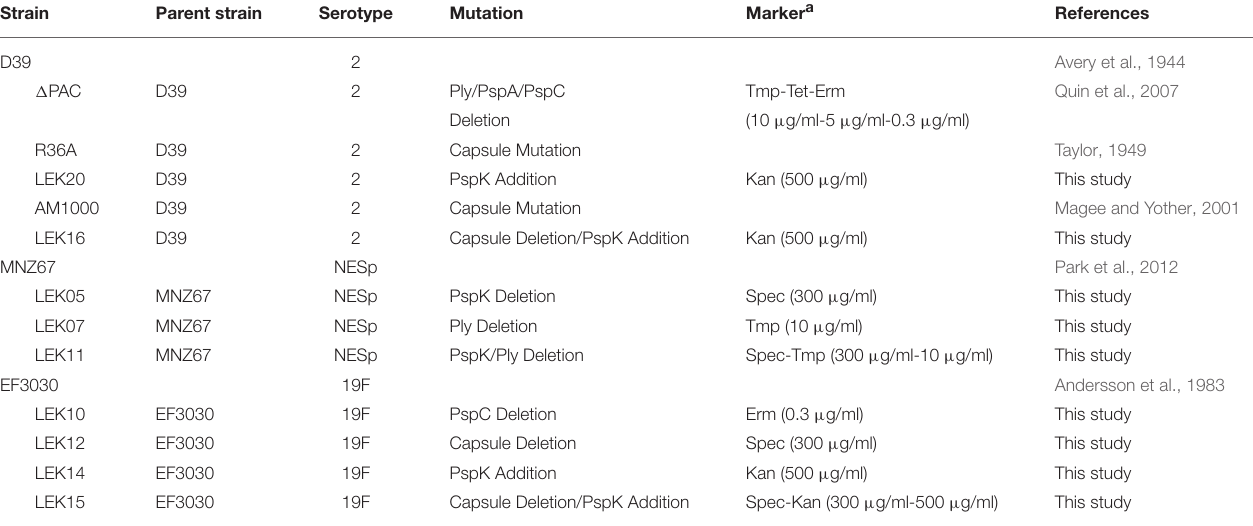
TABLE 1 | Bacterial strains used in this study. Strain Parent strain Serotype Mutation Marker